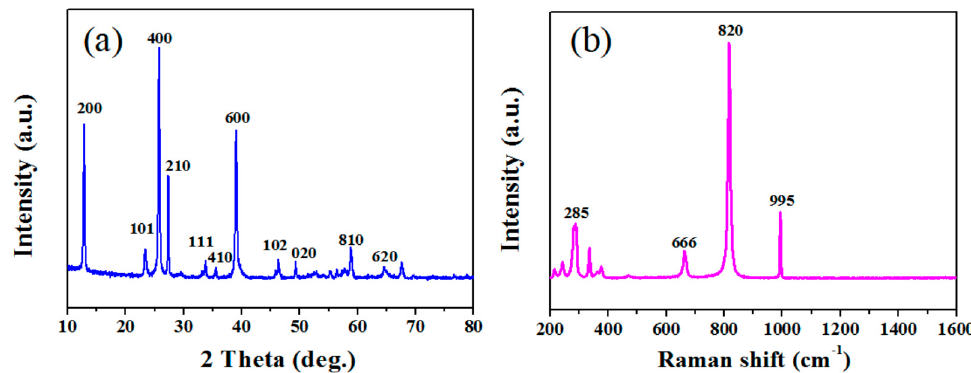
Figure 1. ( a ) XRD pattern and ( b ) Raman spectrum of the synthesized products.